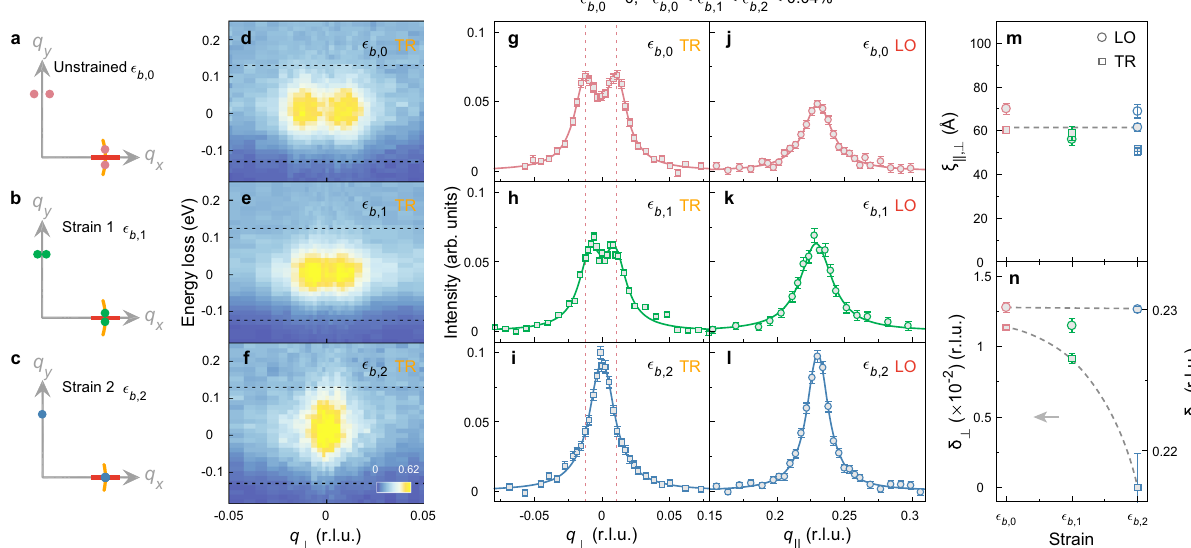
Fig. 2 Evolution of charge-stripe order structure in La 1.88 Sr 0.12 CuO 4 under uniaxial strain. a – c Illustration of the stripe order diffraction pattern as uniaxial pressure is increased. The splitting of stripe order peaks in a , b is exaggerated for clarity. Red and orange thick lines denote longitudinal (LO) and rocking (approximately transverse, TR) scans, respectively shown in g – l for T = 28 K ≈ T c . d – f RIXS intensity maps as a function of energy and q ⊥ , from which scans in g – i are obtained. Black dashed lines, in d – f , mark the energy integration window of elastic intensity. Red dashed lines, in g – i , indicate the fi tted peak positions of the transverse scan at zero strain. m Correlation length and n incommensurability along longitudinal and transverse directions extracted from fi ts (solid lines in g – l ) as described in the main text and Supplementary Information. Open symbols in m denote results obtained on a repeated measurement with strain value comparable to strain 2. Error bars in g – l and m , n are set by counting statistics and standard deviation of fi ttings, respectively. Uniaxial pressure is increased from strain 1 ( ϵ b ,1 ) to strain 2 ( ϵ b ,2 ) by mechanically turning the screw pressing onto the sample. Strain 2 corresponds to the strain value for data shown in Fig.